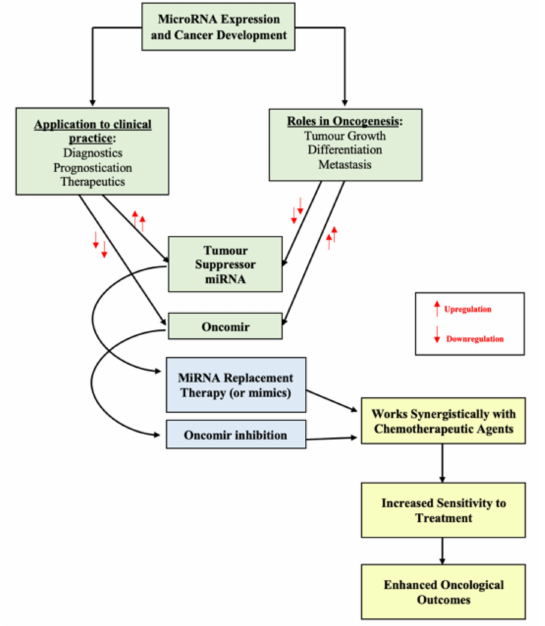
Figure 1. Figure outlining the manipulation of miRNA expression profiles for cancer